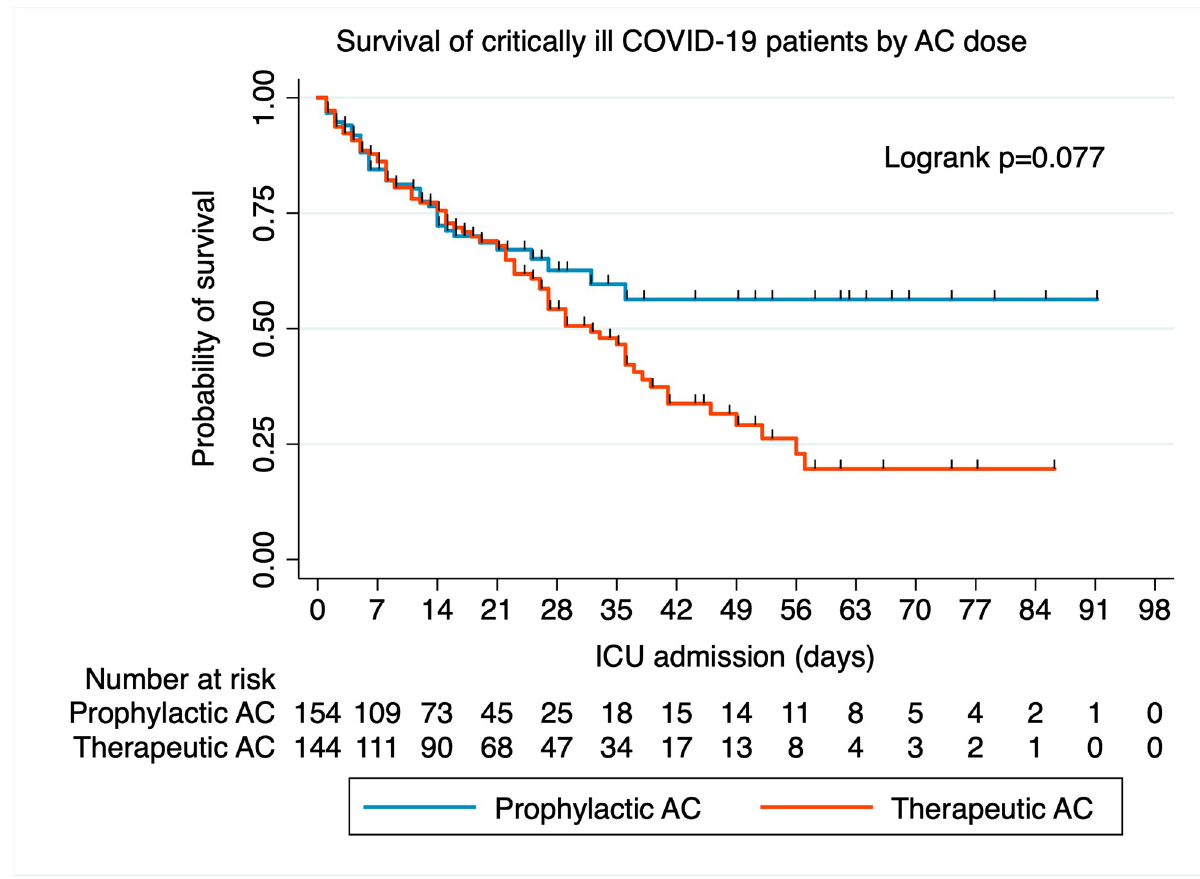
Fig 2. Kaplan-Meier survival plots by anticoagulant treatment. The overall survival functions of critically ill COVID-19 patients who received prophylactic (blue line) or therapeutic (red line) dose anticoagulation are not significantly different from each other ( χ 2 = 3.13, log rank p = 0.077). However, a clear divergence in survival is noted after 3 weeks ICU admission indicating lower probability of survival among therapeutically anticoagulated patients. Hash marks represent censored data. https://doi.org/10.1371/journal.pone.0262811.g002 Table 2. Risk of death for ICU patients with COVID-19 by anticoagulant treatment dosage. Deaths / Person-days Prophylactic dose (ref) Therapeutic dose